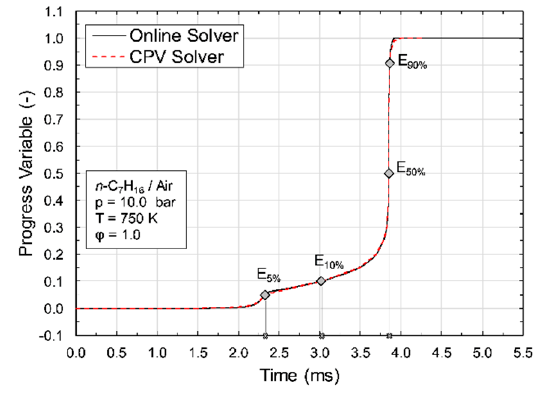
Figure 4. Online and tabulated chemistry solutions for the progress variable (based on Equation (6)) evolution of a stoichiometric n -heptane/air mixture at 10 bar and 750 K.